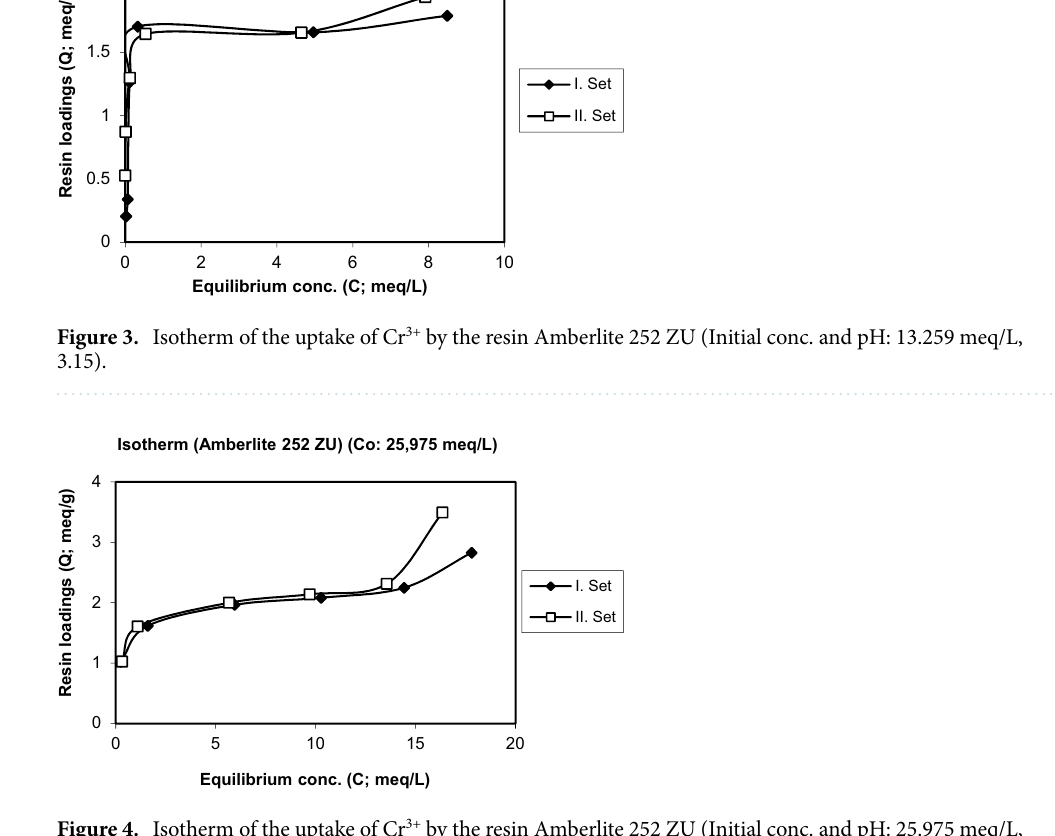
Figure 4. Isotherm of the uptake of Cr 3+ by the resin Amberlite 252 ZU (Initial conc. and pH: 25.975 meq/L,